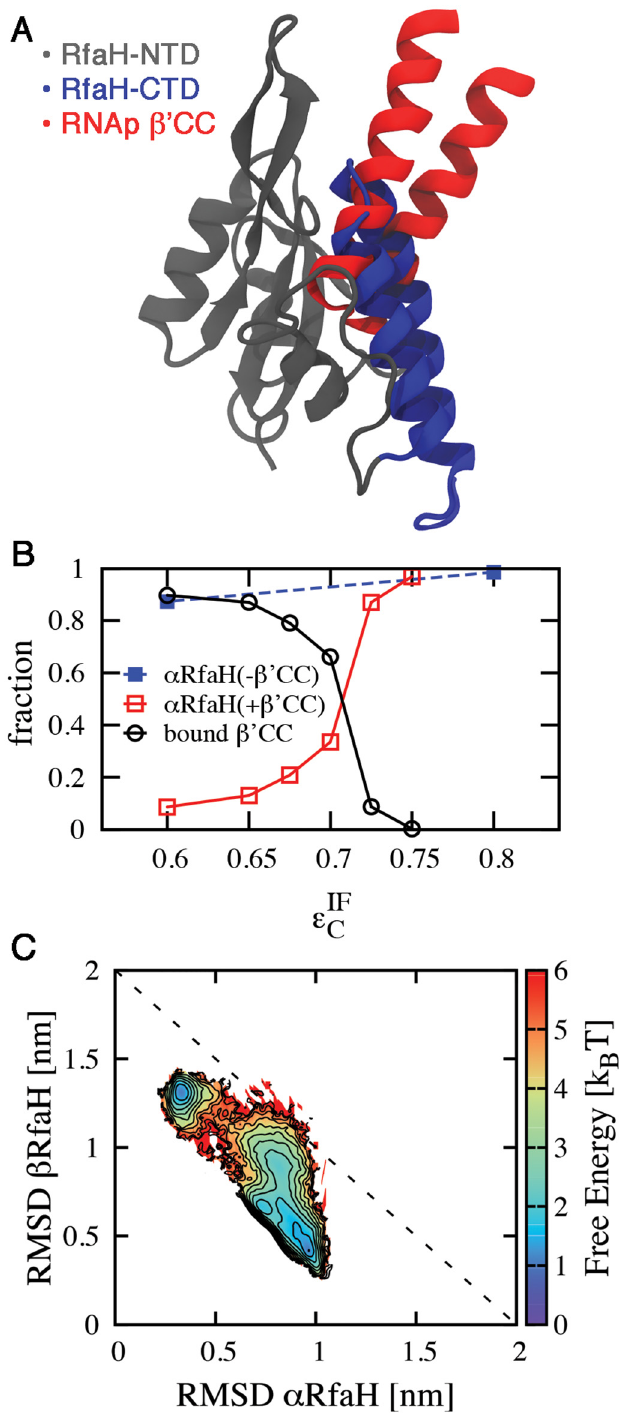
Fig 6. Effect of RNAp binding to the NTD in the folding ensemble of CTD. (A) Structural superimposition of the NTD of the full RfaH protein (gray) and P . furiosus Spt5 bound to RNAp (accession code 3QQC), showing that the CTD in the α fold (blue) occludes the binding site for the β ’ CC of E . coli RNAp, equivalent to the subunit A ’ coiled-coil of P . furiosus RNAp (red). (B) Competitive binding of RNAp β ’ CC to the NTD leads to destabilization of the α fold of the CTD at higher ε IF C values than in the absence of RNAp and is encouraged by reducing the strength of the interdomain interactions. (C) Folding thermodynamics at ε IF C ¼ 0 : 675 ε in